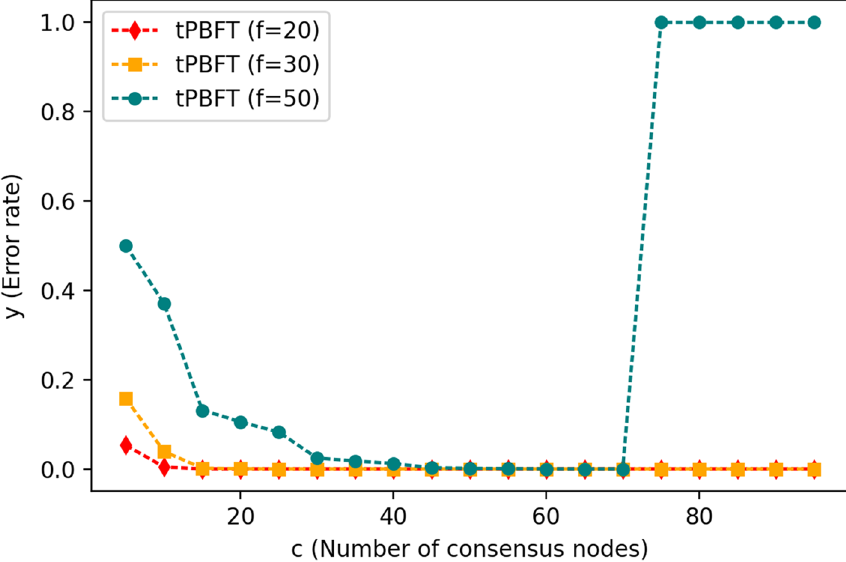
Figure 6. Change chart of consensus transaction volume per second when the number of consensus nodes